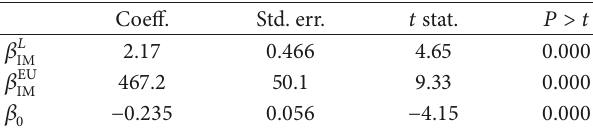
Figure 3: Immigrant inflows and the popularity of right-wing populist movements—a nonlinear threshold . Shown is the annualized immi- grant inflow into a given country (horizontal axis) as a percentage of that country’s population, as well as the corresponding percentage change in RW populist votes (vertical axis). In parentheses are the fractions of immigrants in the total population of the corresponding country. For a group of countries in which the annualized increase in the percentage of RW voters exceeded 2%, this increase is virtually independent of the inflow of immigrants. Such a result may reflect the EU’s political organization, that is, the lack of internal borders whereby if one country decides to accept immigrants, the decision may have repercussions for all the other member states. We also observe a threshold indicated by a dashed line at which the immigrant inflow into a given country is sufficiently high to invariably provoke an increase in the percentage of RW populist voters. In the model construction, this threshold suggests 𝛼 = 0.004 on an annual basis.